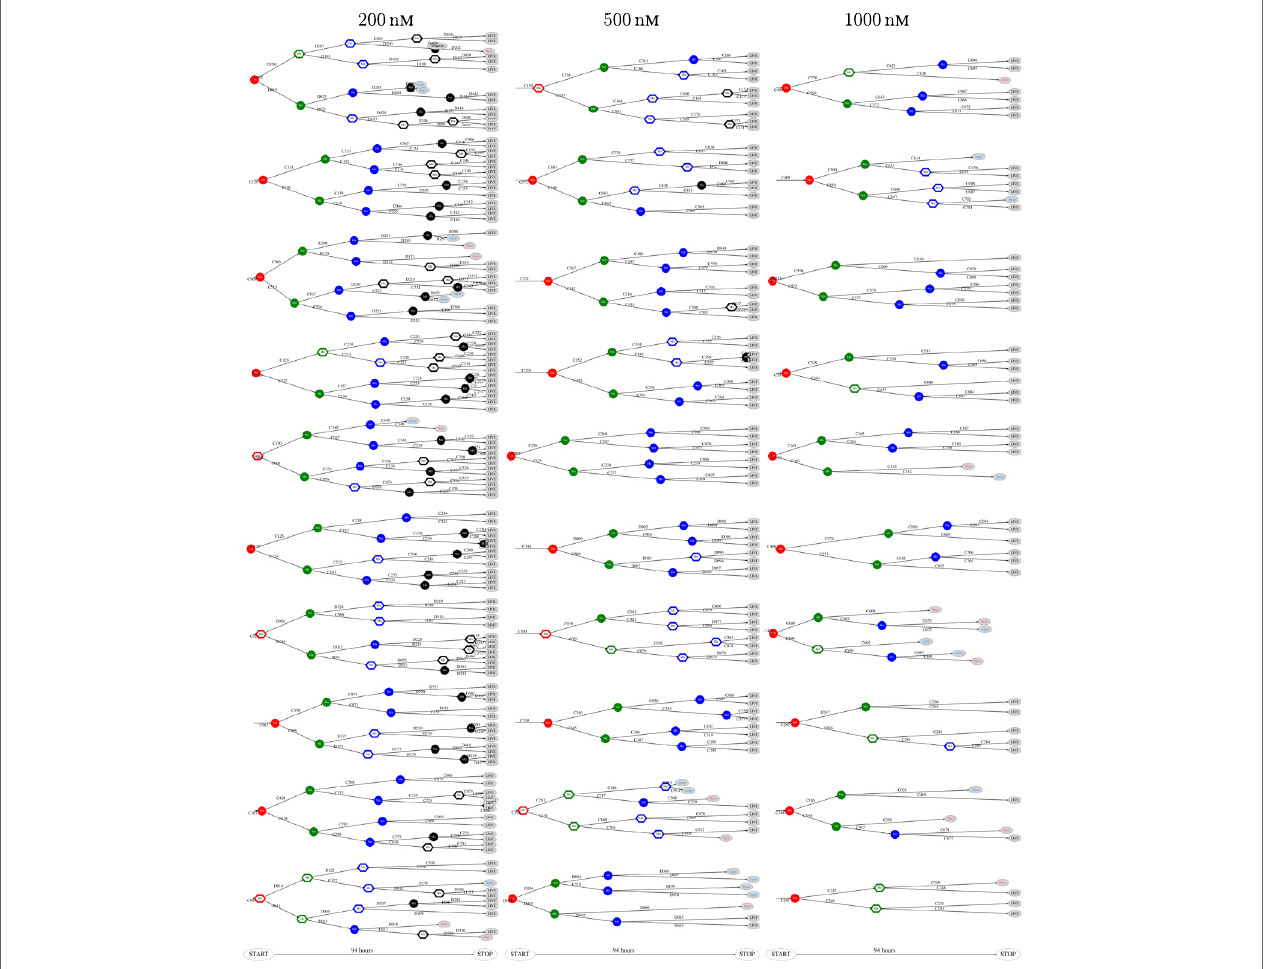
FigUre 6 | The 10 largest pedigree trees for cells exposed to 200, 500, and 1,000 nM (respectively from left to right). Symbols: “Mit” represents mitosis. Circle here represents normal rounding during cell division whereas hexagon represents no normal rounding. “Apop” and “Necr,” respectively, represents apoptosis and necrosis. “LIVE” means the cell still lives at end of